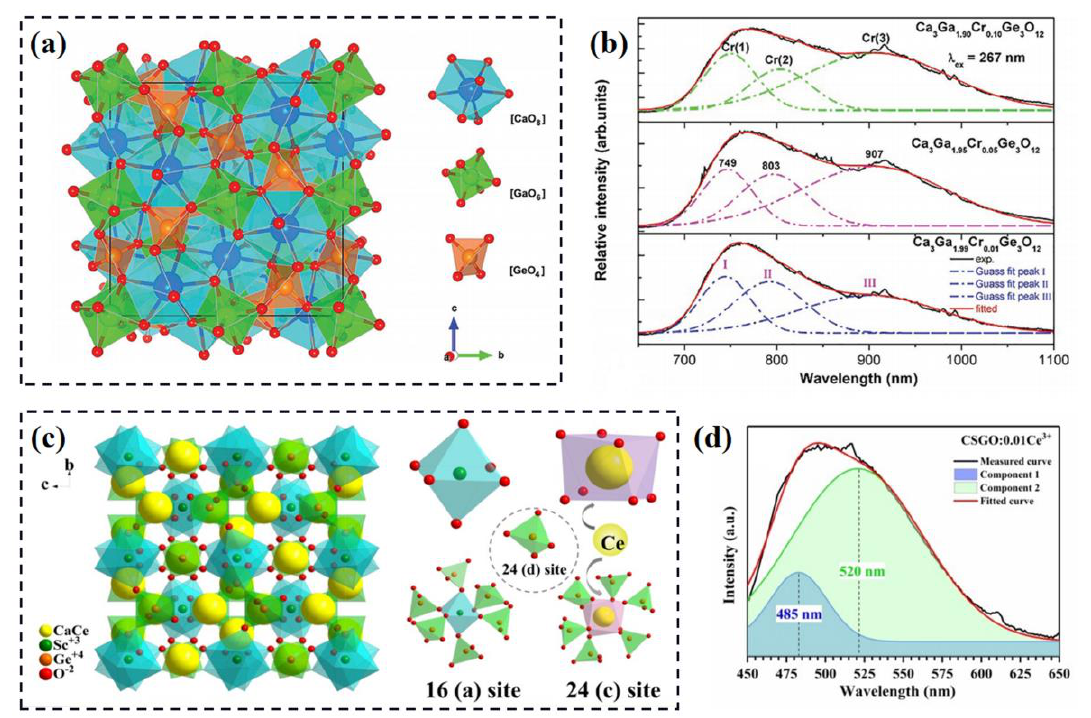
Figure 2. ( a ) Schematic diagram of Ca 3 Ga 2 Ge 3 O 12 structure and coordination environment of Ca 2+ , Ga 3+ and Ge 4+ cations. ( b ) The NIR emission spectra of the samples Ca 3 Ga 2 − x Ge 3 O 12 (x = 0.01, 0.05, 0.10, respectively) under 267 nm excitation at room temperature. Reprinted with permission from ref. [22]. Copyright 2017 WILEY-VCH Verlag GmbH and Co. KGaA, Weiheim. ( c ) Crystal structure of Ca 3 Sc 2 Ge 3 O 12 :Ce 3+ phosphor. ( d ) The decomposed photoluminescence spectrum of Ca 3 Sc 2 Ge 3 O 12 :0.01Ce 3+ phosphor by Gaussian fitting method. Reprinted with permission from ref. [23]. Copyright 2019 Royal Society of Chemistry (London, UK).